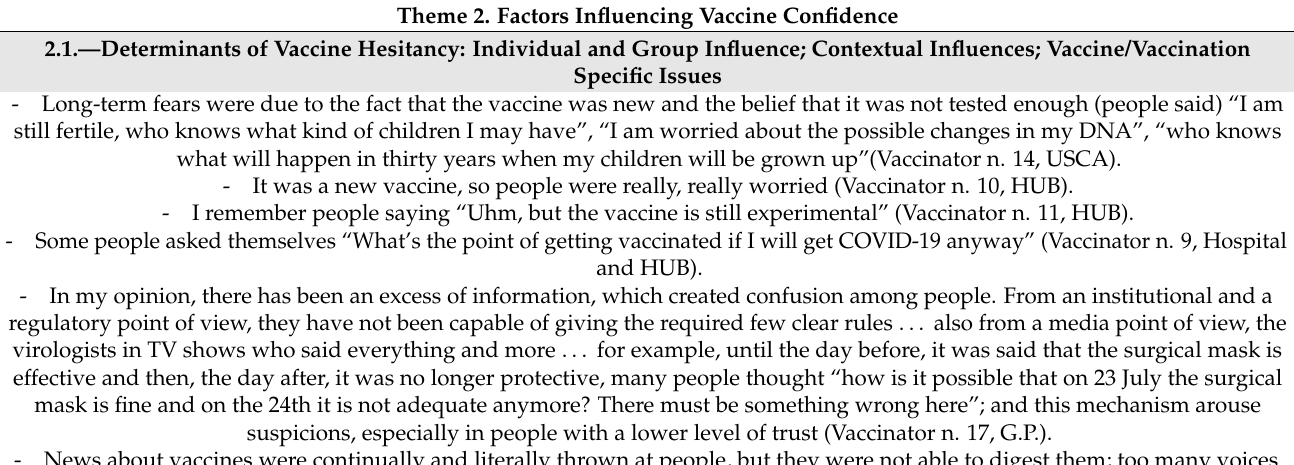
Table 4. Illustrative quotes for theme 2, “factors influencing vaccine